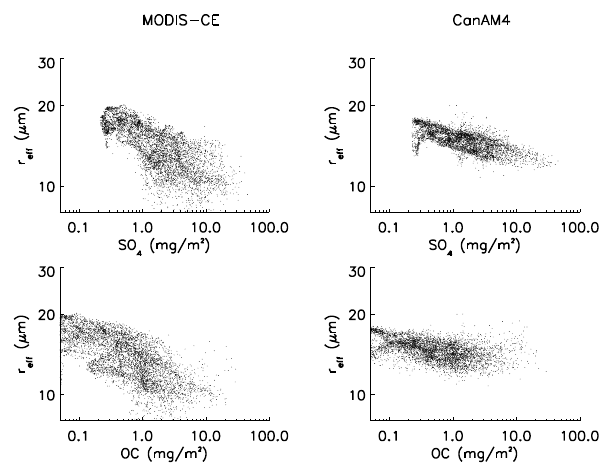
Fig.3. Cloudeffectiveradius( r eff )versusaerosolconcentrationsinJJAforlowlevel(surfaceto700hPa). The Fig. 3. Cloud effective radius ( r eff ) versus aerosol concentrations concentrationsofsulphate(SO 4 )andhydrophylicorganiccarbon(OC)aretakenfromtheCanAM4simulations in JJA for low level (surface to 700hPa). The concentrations of whiler eff isfromMODIS-CEretrievals(leftcolumn)andCanAM4(rightcolumn). sulphate (SO 4 ) and hydrophylic organic carbon (OC) are taken from the CanAM4 simulations while r eff is from MODIS-CE retrievals (left column) and CanAM4 (right